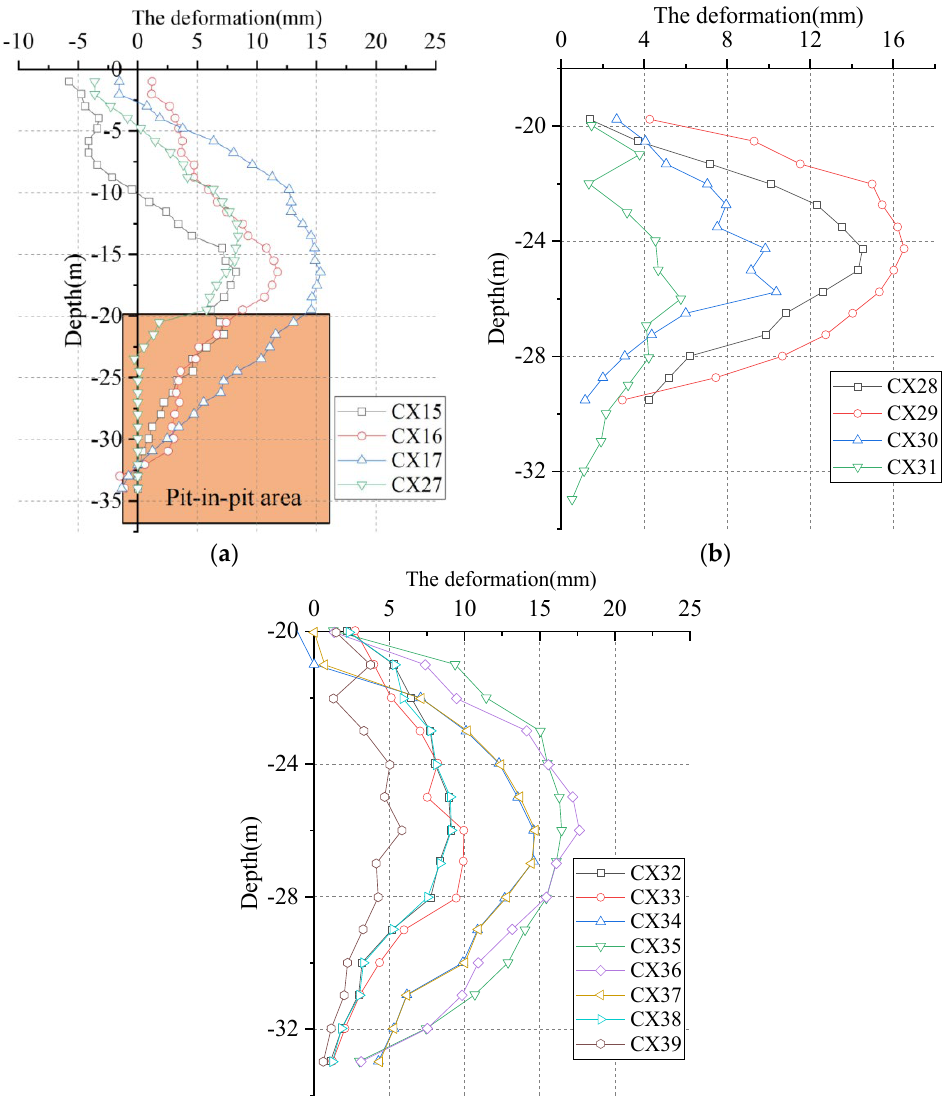
Figure 24. Deep displacement of the retaining structure during pit-in-pit district excavation. ( a ) deep displacement (CX15, CX16, CX17 and CX27). ( b ) deep displacement (CX28, CX29, CX30 and CX31). ( c ) d eep displacement (CX32, CX33, ... and CX39).